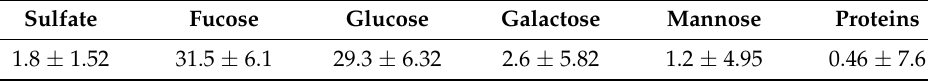
Table 1. Chemical composition (%) of fucoidan extracted from F. hermonis . Data are presented as mean ± S.D. of 3